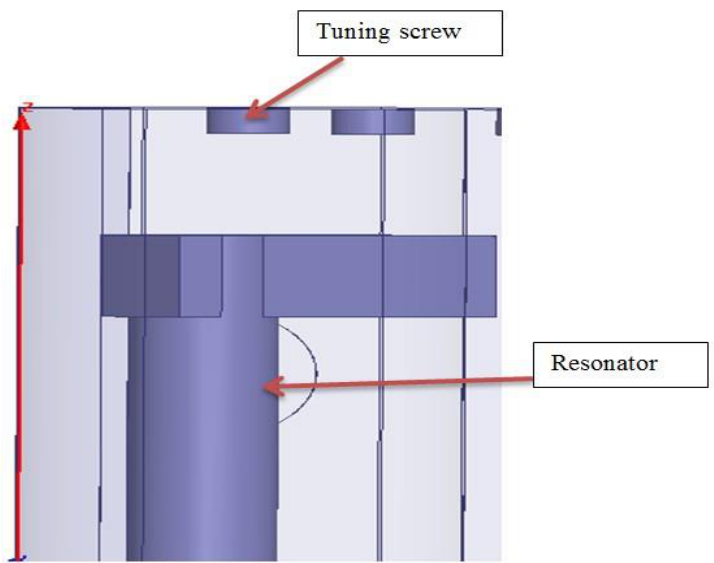
Figure 7. Conventional coaxial resonator (cross-section view).